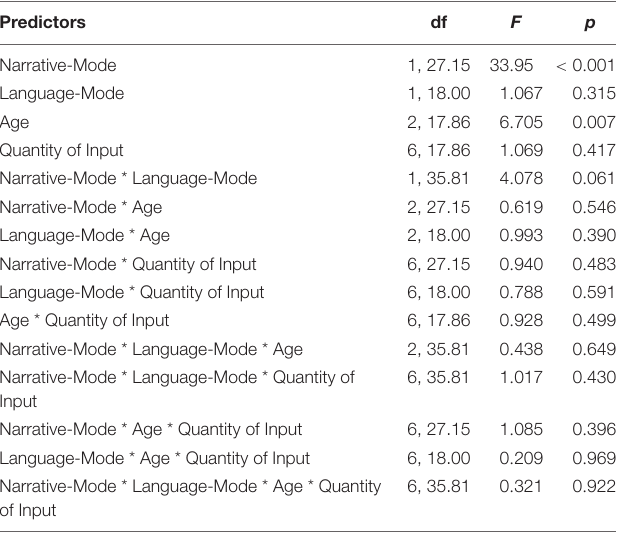
TABLE 3 | Results of the linear mixed model for the dependent variable Story Structure.